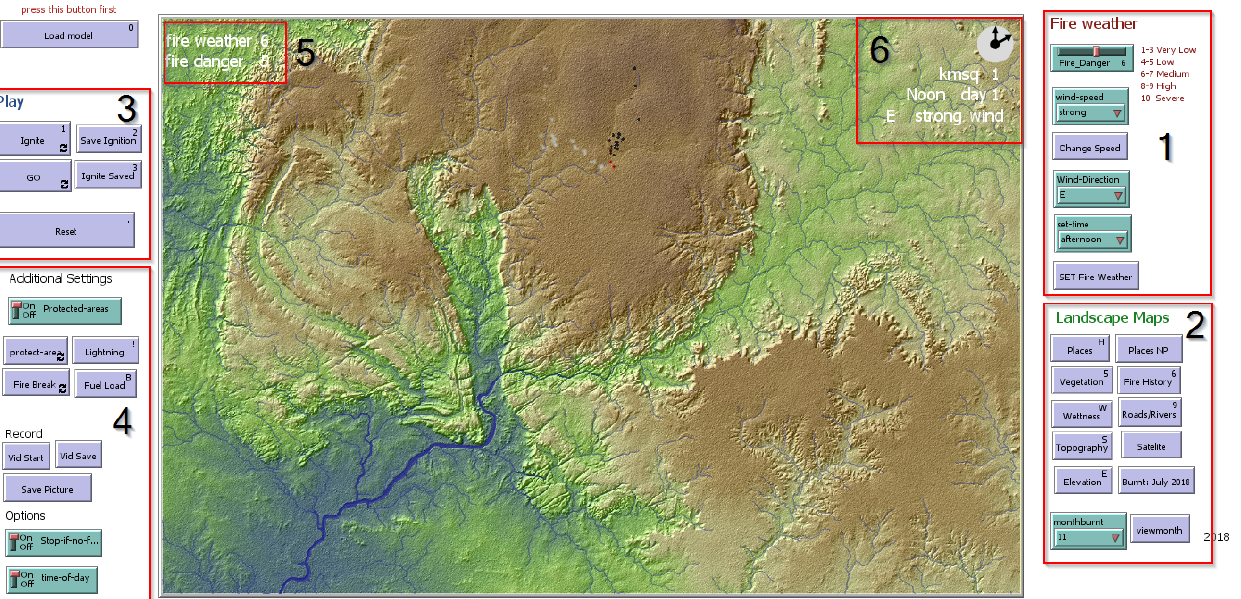
Figure 2. The NetLogo interface showing (1) fire weather, (2) landscape variables, (3) the ignition interface, (4) additional settings to simulate lightning strike or add points of high-value areas needing protection, (5) fire danger monitor, and (6) the area burnt, winds speed, and time monitoring.